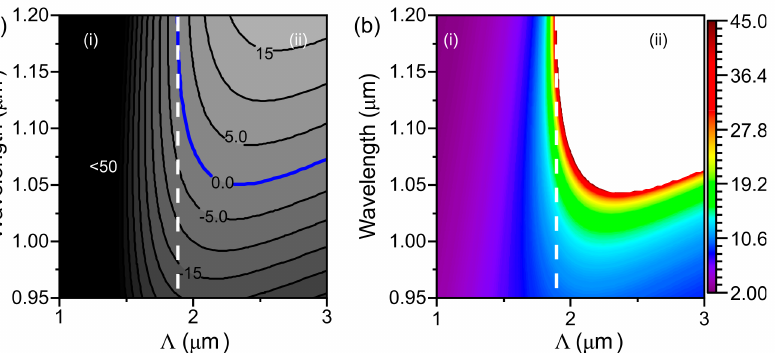
Figure 2. ( a ) Chromatic dispersion as a function of optical wavelength and fiber pitch for air-filled PCFs. Numbers indicates dispersion levels in ps/km · nm. White dashed line indicates pitch of 1.8 µ m. ( b ) Frequency shift map of polarization modulation instability (PMI–SF); color bars are detuning frequencies values in THz. Parameters used in the simulations: d/ Λ = 0.36, P = 3